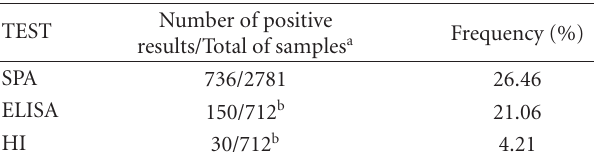
Table 1: Frequency of anti-MS antibodies using SPA, HI, and ELISA in Mycoplasma synoviae diagnosis in commercial poultry breeder flocks a